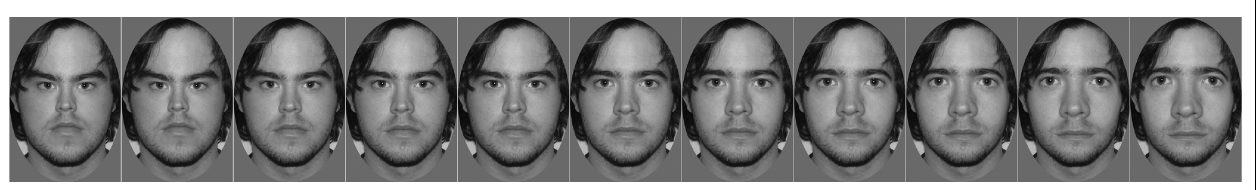
FIGURE 1 |An original, undistorted face is shown in the center with increased expansion and compression toward the right and left sides, respectively.